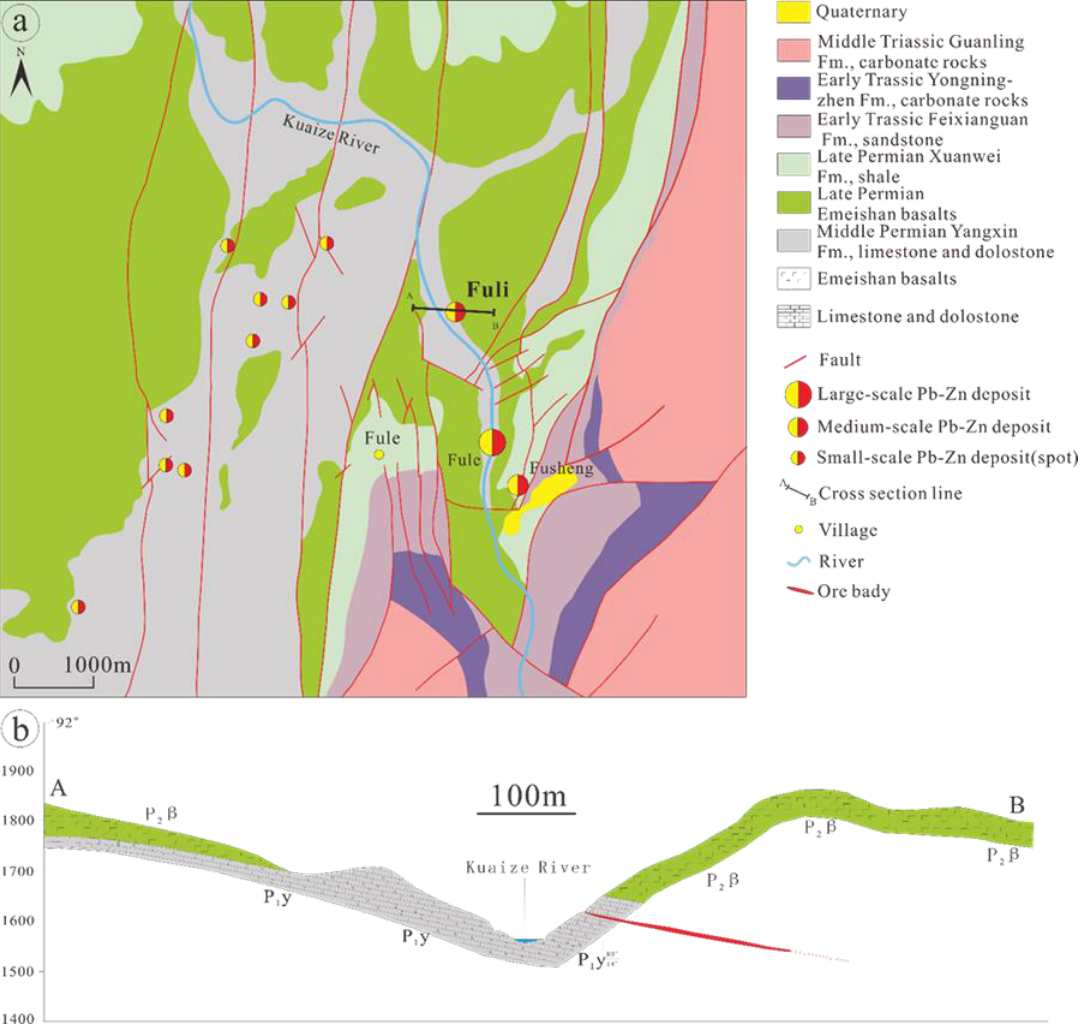
Figure 2. ( a ) Geological sketch map of the Fuli Pb−Zn deposit (modified after [6]Zhou et al., 2018). ( b ) A-B Cross-section of the Fuli deposit.